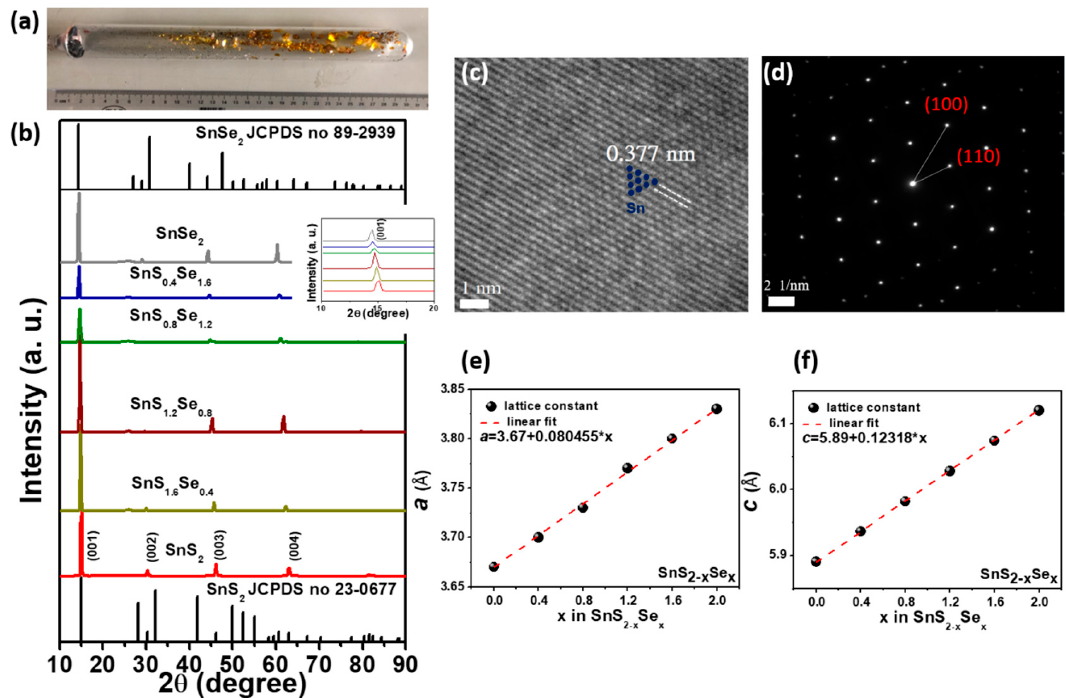
Figure 1. ( a ) Macroscopic single crystals synthesized from the CVT method. ( b ) XRD patterns of SnS 2-x Se x layered crystals with varying Se composition. The inset is the magnified (001) peak. ( c ) High resolution transmission electron microscopy (HRTEM) image and ( d ) selected area electron diffraction (SAED) pattern. ( e , f ) Variation of lattice constants a and c of SnS 0.8 Se 1.2 crystal. Table 1. The composition x of the SnS 2-x Se x alloys assessed by electron probe X-ray micro-analyzer (EPMA) and lattice constants a and c deduced from HRTEM and XRD, respectively.